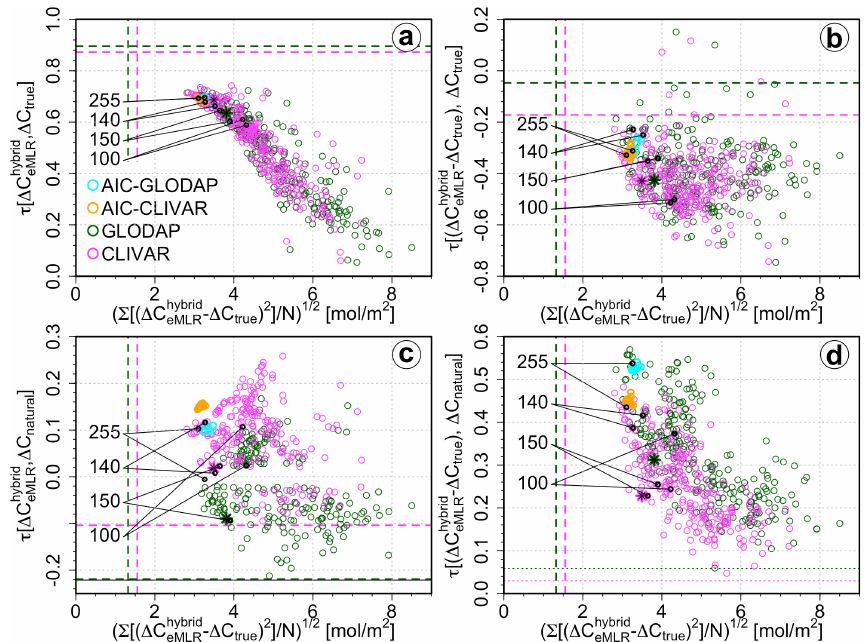
Fig. 14. Kendall correlation coefficients ( τ ) calculated between the column inventory changes predicted by all eMLR solutions obtained with a variable sampling network (strategy 1 and 2, 1C hybrid ) and (a) the true or (c) the mapped natural carbon change plotted as a function X of each model’s RMSE relative to the true values. (b, d) Corresponding correlations calculated using the absolute error patterns. Only correlations with p ≤ 0.05 are plotted. The RMSE due to mapping only are shown by vertical green (GLODAP) and magenta (CLIVAR) lines. Correlations calculated using the true mapped values instead of the eMLR results are shown as horizontal green (GLODAP) and magenta (CLIVAR) lines; thin dotted lines in (b) mean correlations are not significant at α = 0 . 05. The solid horizontal gray line in (c) shows the correlations between the true values (no mapping) and the natural carbon change pattern.